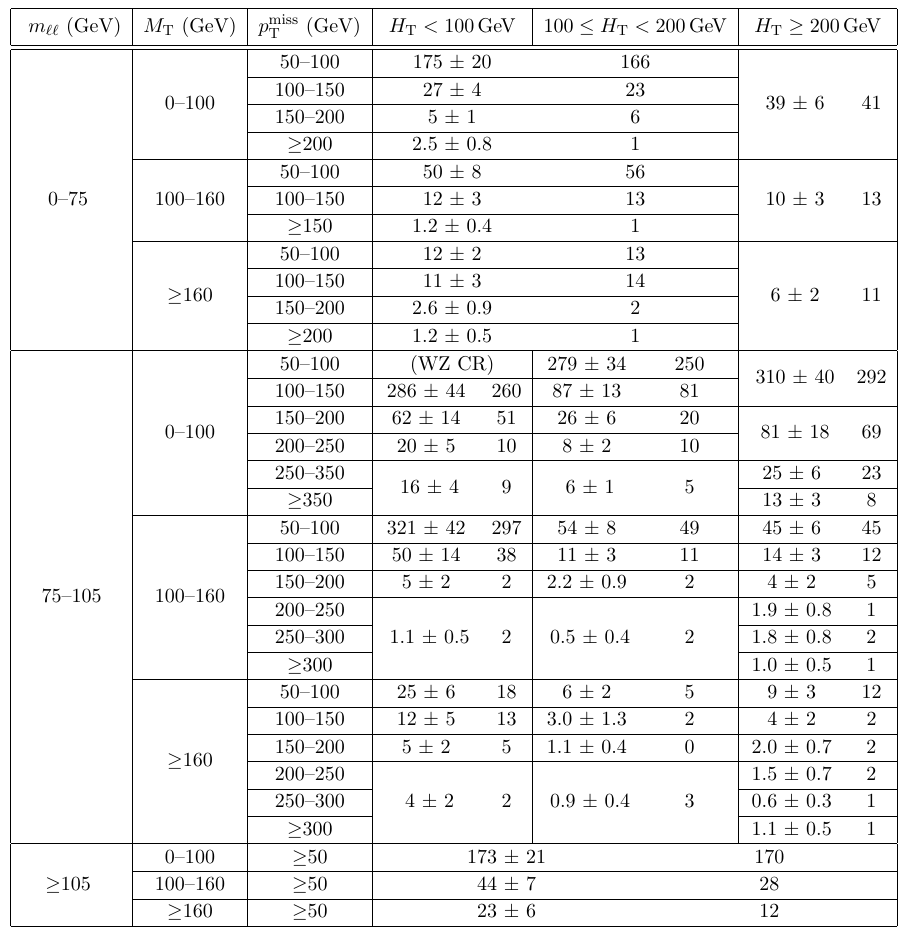
Table 3 . Expected and observed event yields in the search regions. For each bin, the (cid:12)rst number corresponds to the expected yield and its total uncertainty while the second number gives the observation. Where ranges of values are given for the selections, the lower bound is inclusive